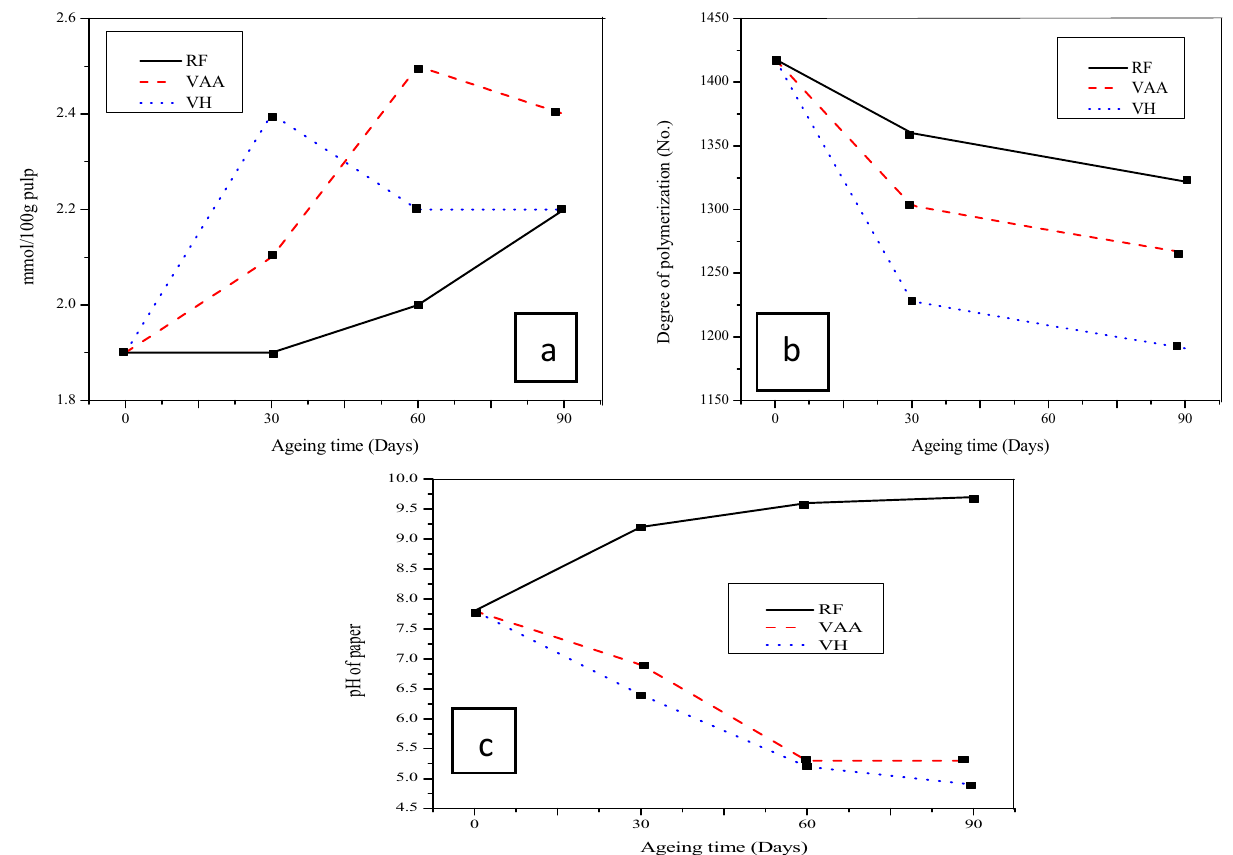
Figure 3. Effects on ( a ) carbonyl content, ( b ) DP, and ( c ) pH of paper due to expose in VOCs environments.